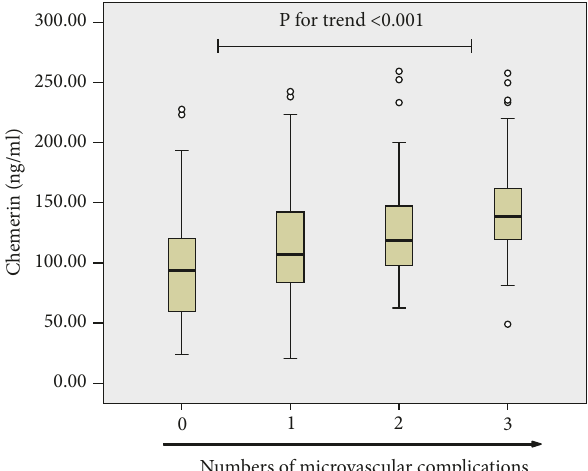
Figure 2: Plasma chemerin concentrations in relation to the number of diabetic microvascular complications . As shown, plasma chemerin concentrations elevated significantly with increasing number of microangiopathic complications in diabetes. P-value for significant difference between the groups was determined by the one-way analysis of variance